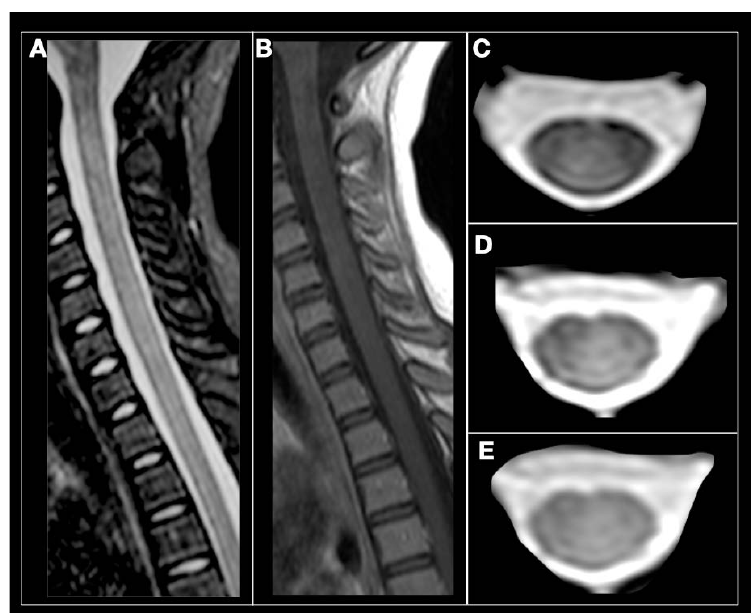
Figure 4. Anti-MOG antibody myelitis. A 12-year-old girl with relapse in the cervical spine. ( A ), sagittal STIR, subtle and diffuse hyperintensity of the cervical spinal cord. ( B ), Sagittal T1-weighted, STIR, subtle and di ff use hyperintensity of the cervical spinal cord. ( B ) Sagittal T1-weighted, spinal spinal cord is isointense without contrast enhancement. ( C – E ), axial T2-weighted images showing cord is isointense without contrast enhancement. ( C – E ) axial T2-weighted images showing subtle and subtle and diffuse spinal cord hyperintensity (Courtesy Dr Angeles Schteinschnaider). di ff use spinal cord hyperintensity (Courtesy Dr. Angeles